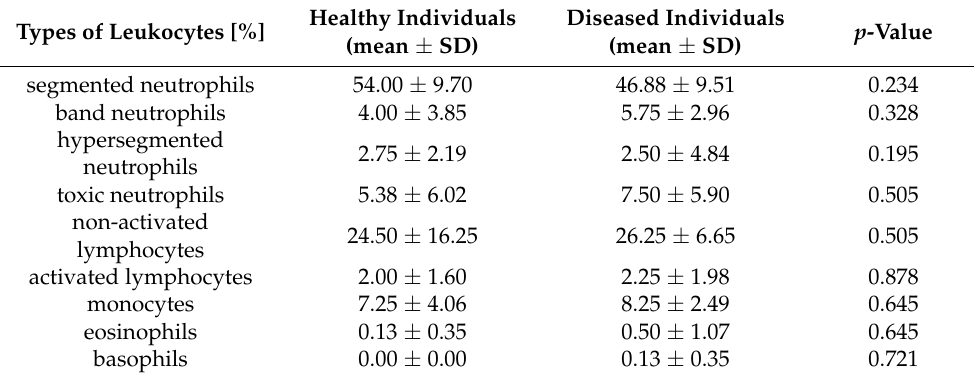
Table 1. Leukogram results of healthy and diseased bitches.